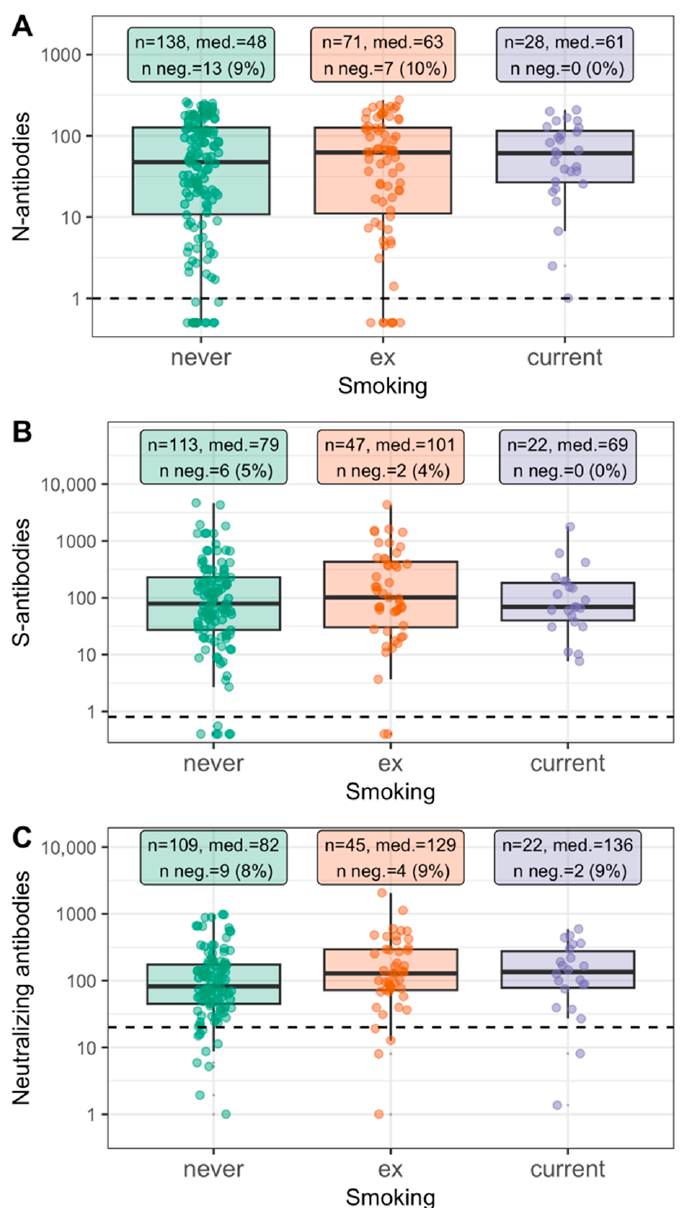
Figure 2. Antibody levels at FU2 among individuals with positive PCR test by smoking status. Shown are antibody levels at FU2 among individuals with positive PCR test in the study period (reported positive and health authority-validated, until April 2021, n = 237, including 28 current smokers): ( A ) N-specific antibodies, ( B ) S-specific antibodies (restricted to unvaccinated participants), ( C ) neutralizing antibodies (restricted to unvaccinated). Dotted line marks threshold for binary seropositivity. Indicated are sample size, median antibody level, number (%) of individuals seronegative for the respective antibodies. N-specific antibodies: Arbitrary Units (AU)/mL; S-specific antibodies: Binding Antibody Units (BAU)/mL; Neutralizing antibodies: Inhibitory Dose 50 (ID50).